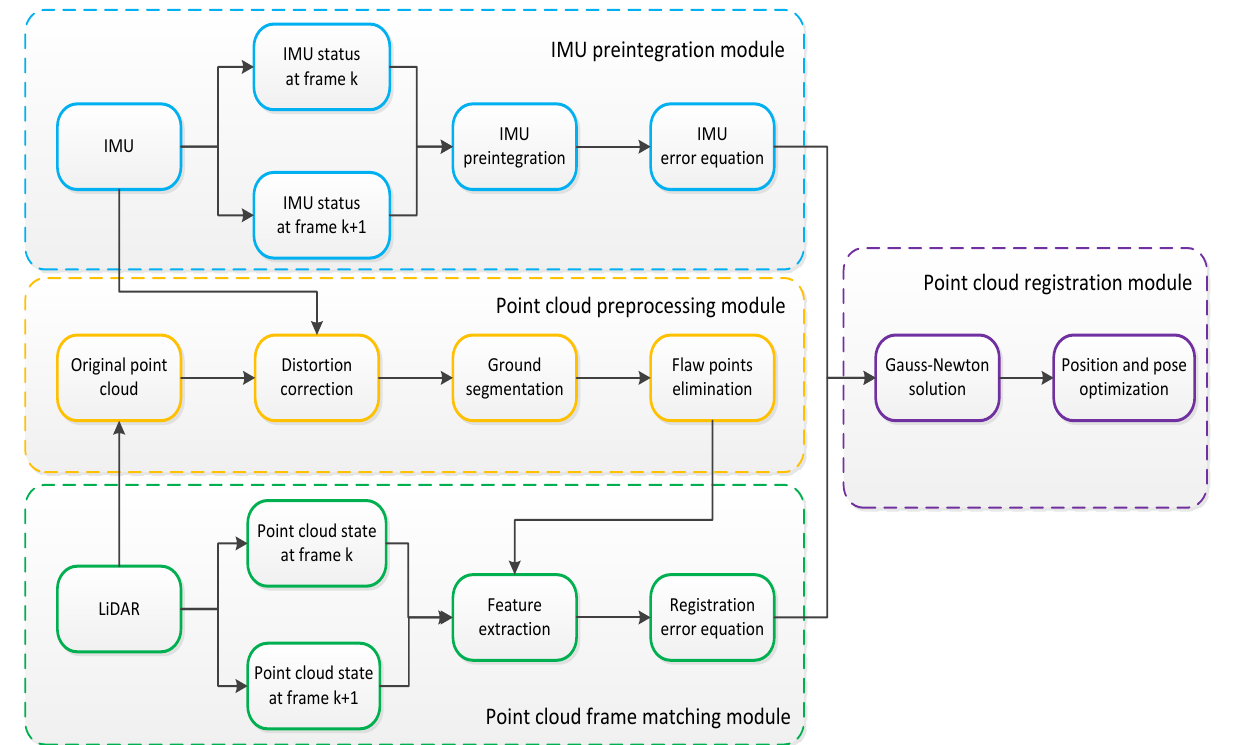
Figure 1. System framework diagram.